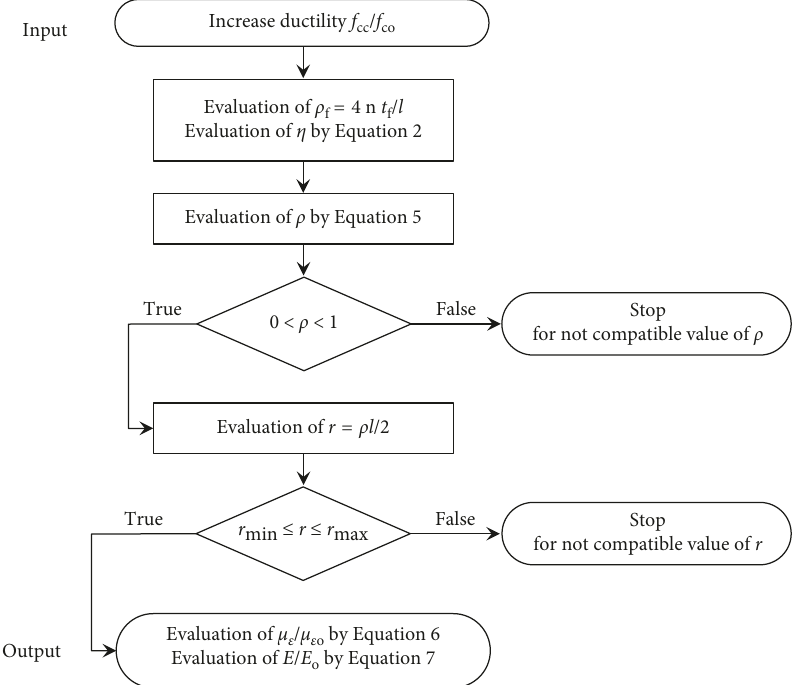
Figure 13: Flowchart for design procedure in the case of fixed increased